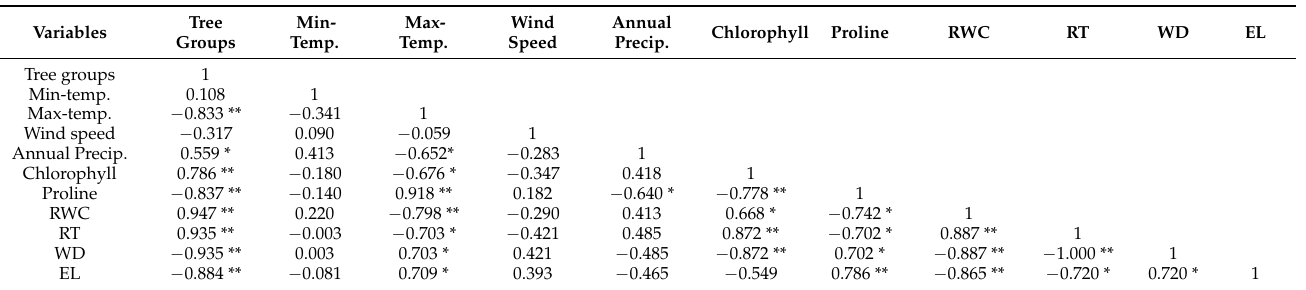
Table 2. Pearson correlation between climatic factors and physiological indices of two groups of J. seravschanica existing in the Genow habitat. Variables Tree Groups Tree